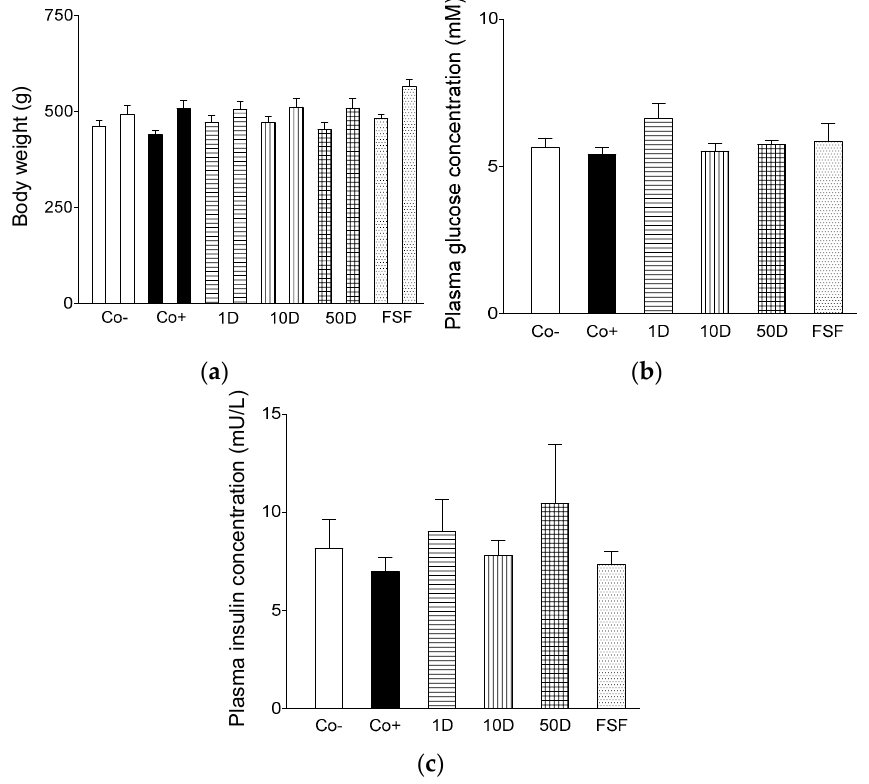
Figure 1. The effect of high-fat, high-sugar diet (HFHSD) (positive control: Co+), 2 g/kg bw/day fenugreek seed flour in addition to HFHSD (FSF), 1, 10 and 50 mg/kg bw/day diosgenin in addition to HFHSD (1D, 10D and 50D, respectively) on the body weight ( a ), fasting plasma glucose level ( b ) and fasting plasma insulin level ( c ) of Wistar rats. The negative control group (Co − ) consisted of rats receiving conventional rat food and tap water. In the panel ( a ), the left one of columns with the same color and pattern indicates the initial body weight, while the right one shows the body weight after the 6-week dietary treatment. The columns represent the average values of the given groups (+SEM).